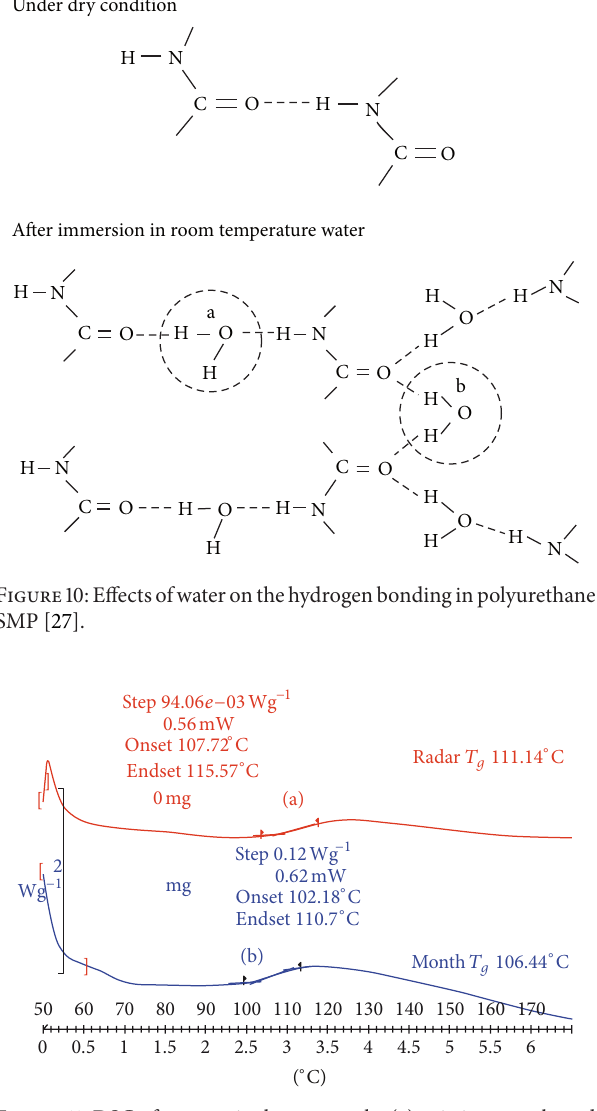
Figure 11: DSC of a 5mg vinylester sample: (a) pristine sample and (b) after 9 months of